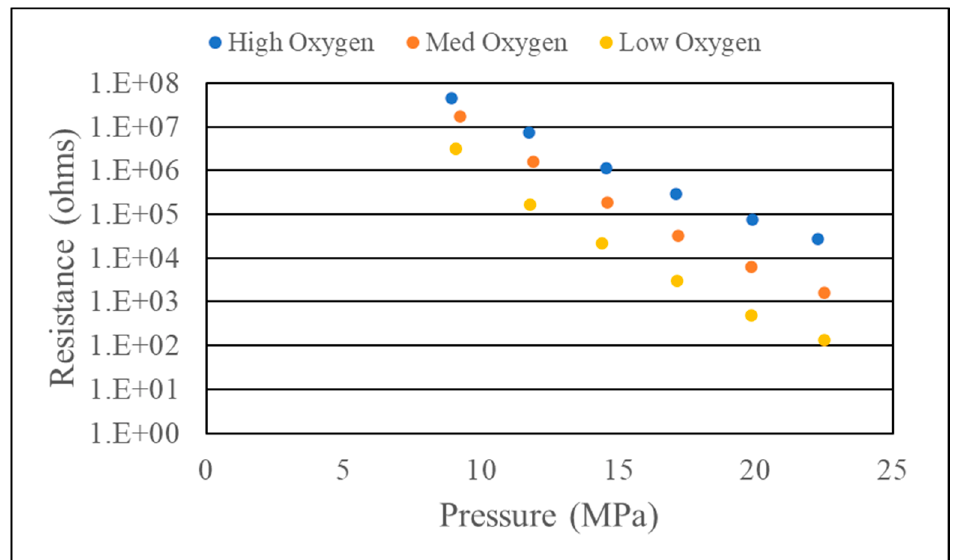
Figure 21. Compressibility data for the evaluated AL6061 powders.